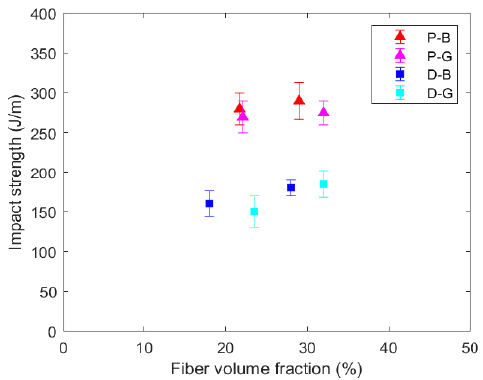
Figure 8. Scatter diagram of the impact strength of the GF/PA6 specimens by fiber volume fraction.